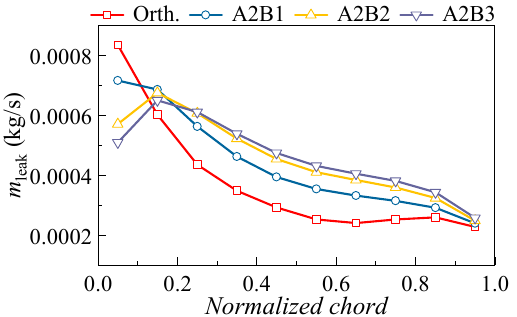
Figure 13. The comparison of the streamwise leakage mass flow rate under different sweep angles ( φ = 0.46).